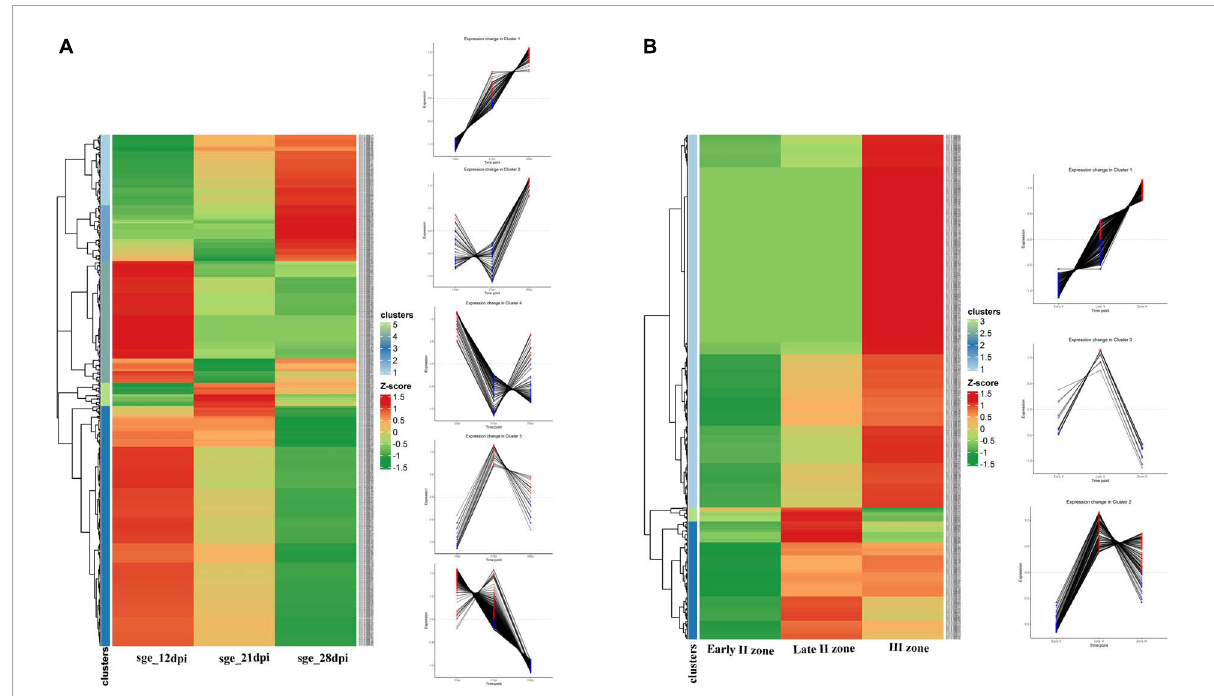
FIGURE5 (A) Cluster analysis of P. sativum NCR genes on the basis of the expression pattern change at the different stages of symbiosis. MACE sequencing data of wild-type line SGE at 12, 21, and 28 dpi. (B) Cluster analysis of P. sativum NCR genes on the basis of the expression pattern change at the different stages of nodule development. RNA sequencing data of wild-type line SGE in early II nodule zone and late II and III nodule zones. All log2(CPM) expression values were transformed into z -score to build heatmaps.